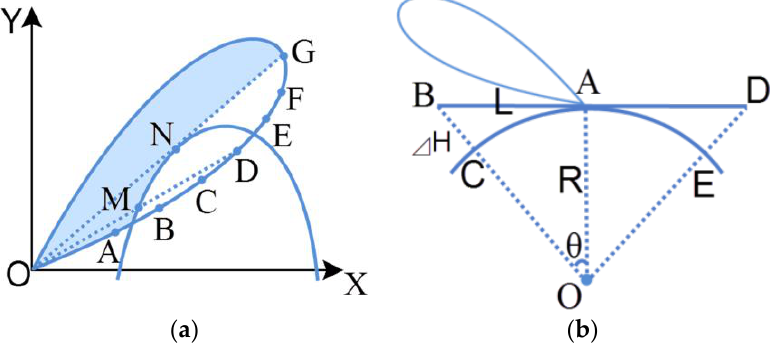
Figure 5. ( a ) Radar signal propagation; ( b ) Earth curvature's influence.